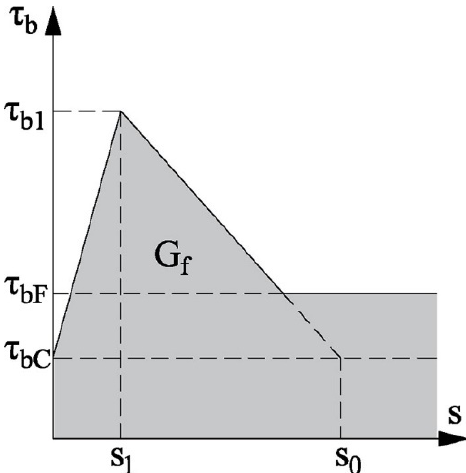
Figure 3. Modified bond law for the more accurate method.